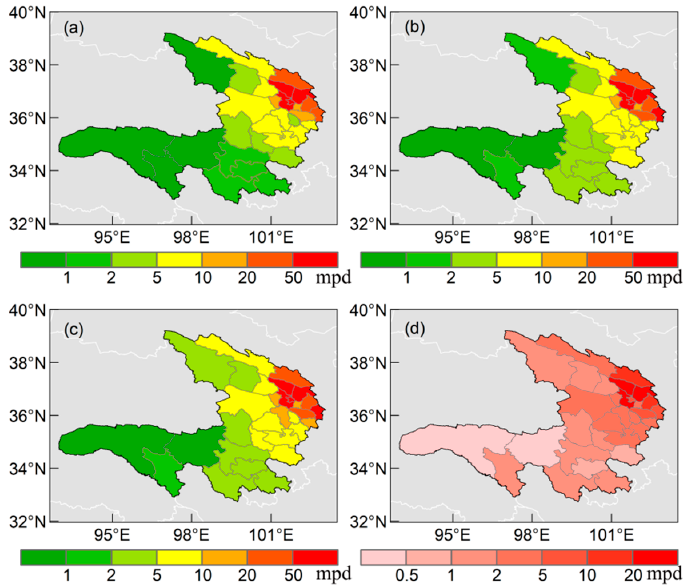
Figure 8. Spatial distribution of population exposure to rainstorm disasters upstream of the Yellow River Basin at around 2050 (2036–2065) in future scenarios: ( a ) low-discharge scenario SSP126, ( b ) medium-discharge scenario sSSP245, ( c ) high-discharge scenario SSP370, ( d ) difference in popula- tion exposure between high- and low-discharge scenarios.